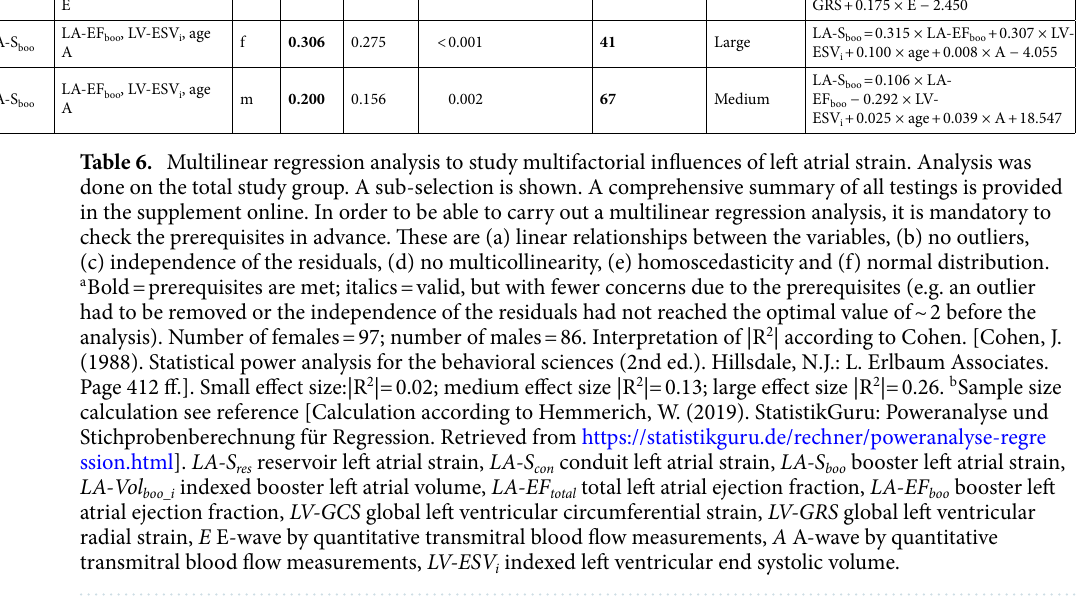
(III) multiparametric analyses achieved a higher correlation value in the heart rate subgroup of 60–75 beats per minute, and (IV) percentile plotting imply changes in cardiac remodeling at age 40–45 years. Influence of heart rate on left atrial strain. As shown in Supplement S1, Table I, left atrial reservoir strain and left atrial conduit strain increase with higher heart rate in the total cohort by bivariate linear regres- sion analysis. This is in line with a recent MRI study by Weise Valdés et al. in which an increase in global longi- tudinal, circumferential and radial strain with increasing heart rate was also observed, but in the left ventricle of healthy subjects 15 . Consistent with our observations, they found significantly elevated left ventricular strain in